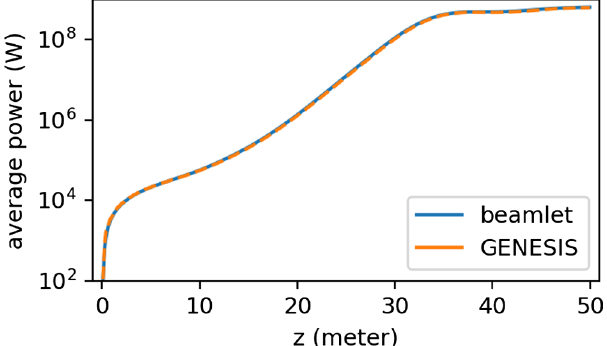
FIG. 5. Bench mark between GENESIS v.1.3 and beamlet migration of SASE simulation using Next Generation Light Source (NGLS) parameters [23]. Blue is the beamlet migration. Dashed orange is GENESIS v.1.3 .